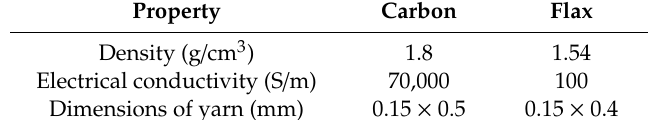
Table 1. Physical and electrical properties of materials.